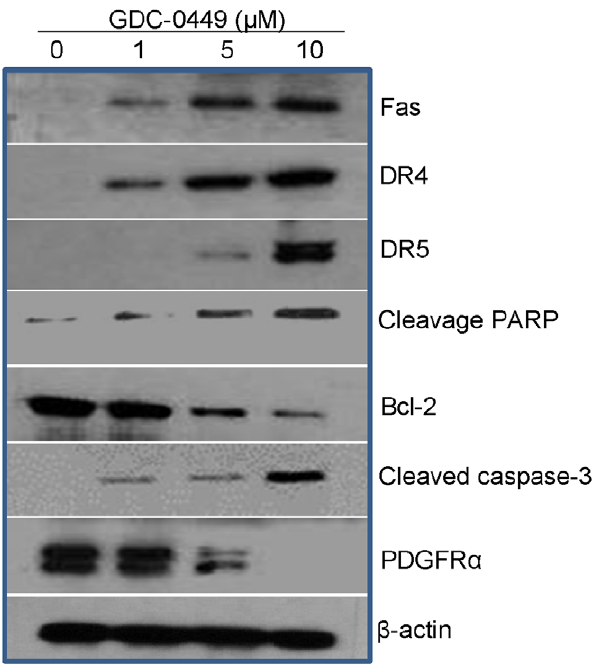
Figure 4. GDC-0449 differentially regulates genes involved in the balance between cell death and cell survival. Pancreatic CSCs were treated with GDC-0449 (0, 1, 5 and 10 m M) for 48 h. The expression of Fas, DR4/TRAIL-R1, DR5/TRAIL-R2, PARP cleavage, Bcl-2, and Caspase-3 by the Western blot analysis. b -Actin was used as a loading control.